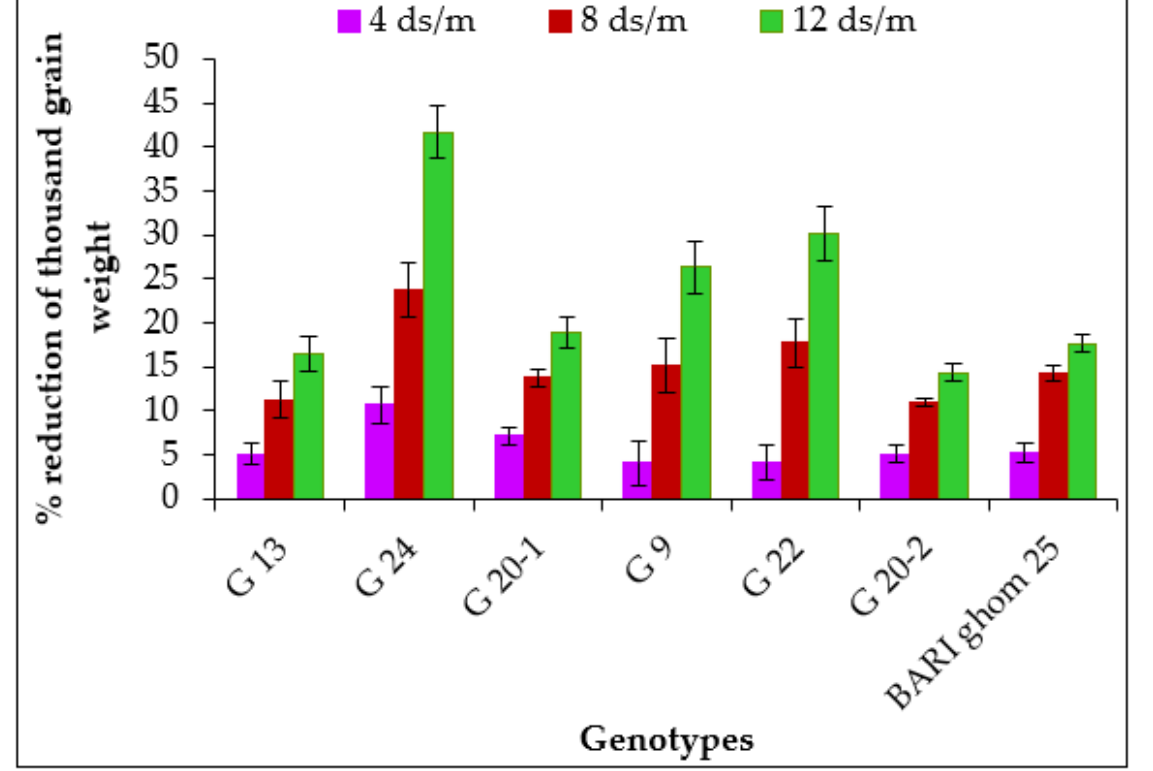
Figure 7. Reduction (%) of thousand grain weight of wheat genotypes under various salinity levels. The vertical bar indicates average of five independent replicates ( n = 5). Error bars represent standard error.